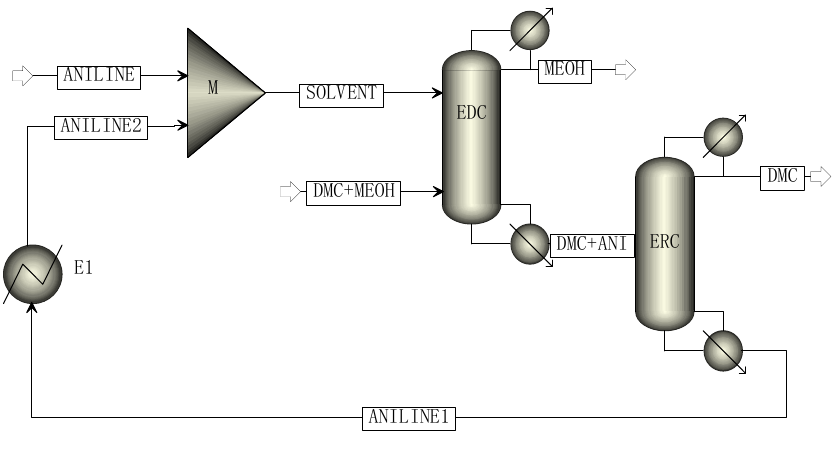
Figure 4. The simulation process of EDWC.